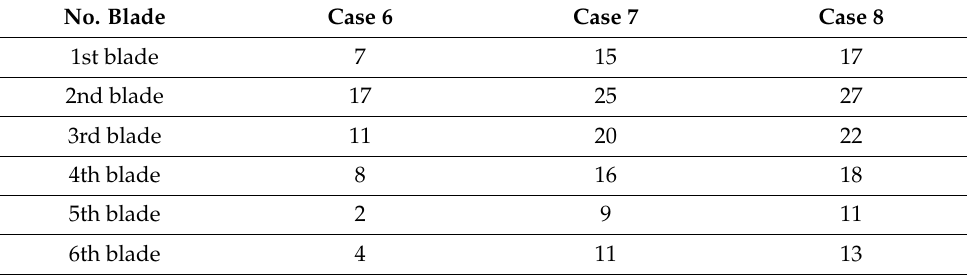
Table 9. Pitch angles of Cases 6, 7, 8.